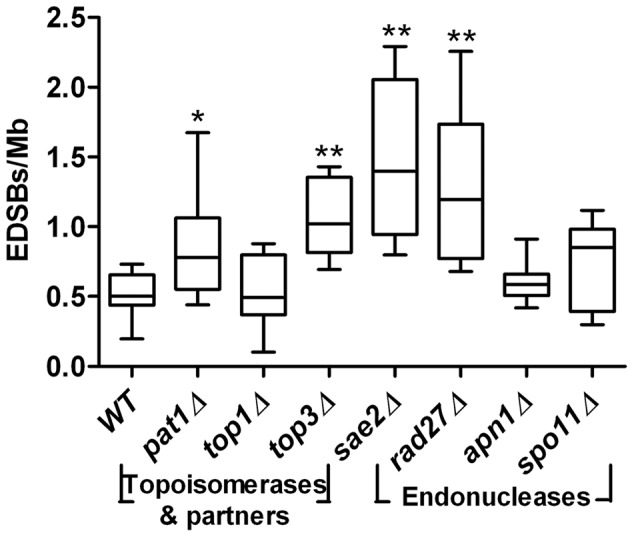
RIND-EDSBs in strains with mutations in genes encoding topoisomerases, their partners, and endonucleases.Deletions of genes encoding topoisomerases, their partners, and endonucleases did not reduce the levels of RIND-EDSBs in G0 cells. On the contrary, the levels of RIND-EDSBs were increased in G0 cells of top3Δ, rad27Δ, and sae2Δ strains. The values from 9 independent experiments are shown as box plots, with the boxes representing the interquartile ranges (25th to 75th percentile) and the median lines representing the 50th percentile. The whiskers represent the minimum and the maximum values. *P<0.05, **P<0.001(Mann-Whitney test).